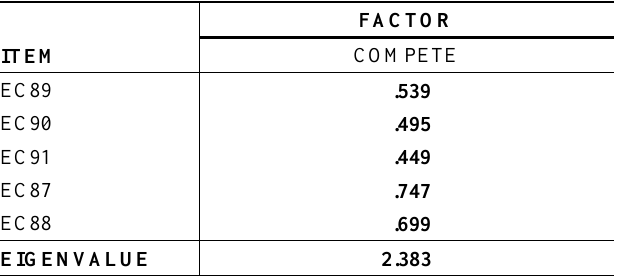
Table 3: Rotated factor loadings: Dependent variable